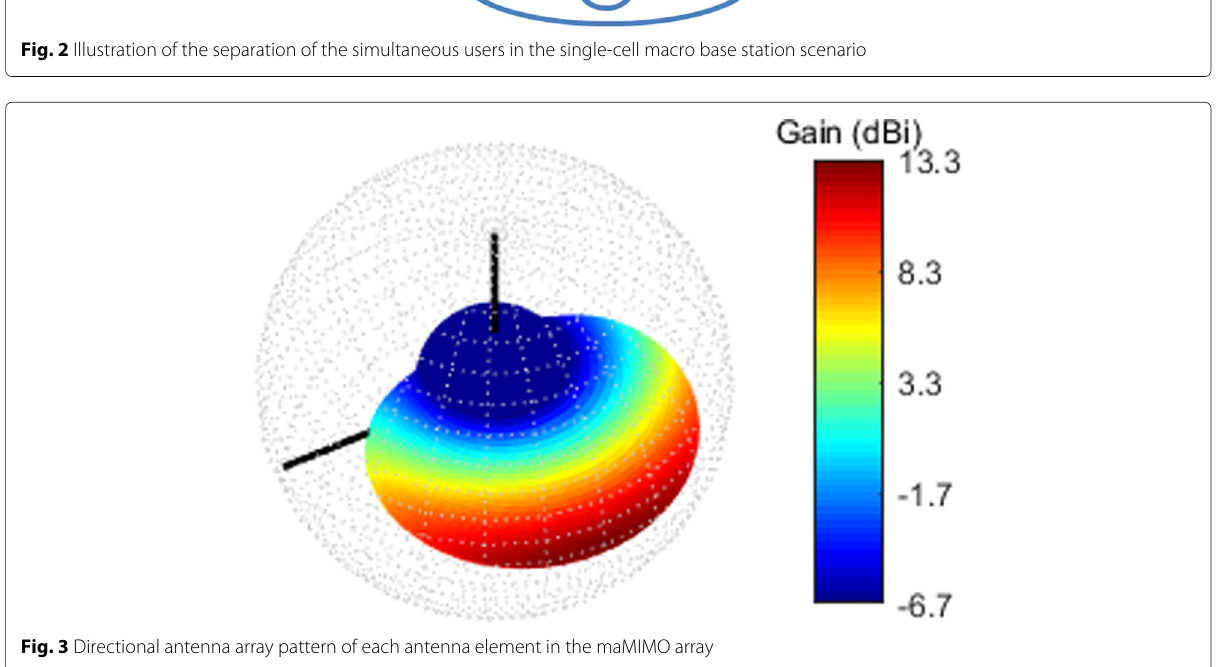
Fig. 3 Directional antenna array pattern of each antenna element in the maMIMO array